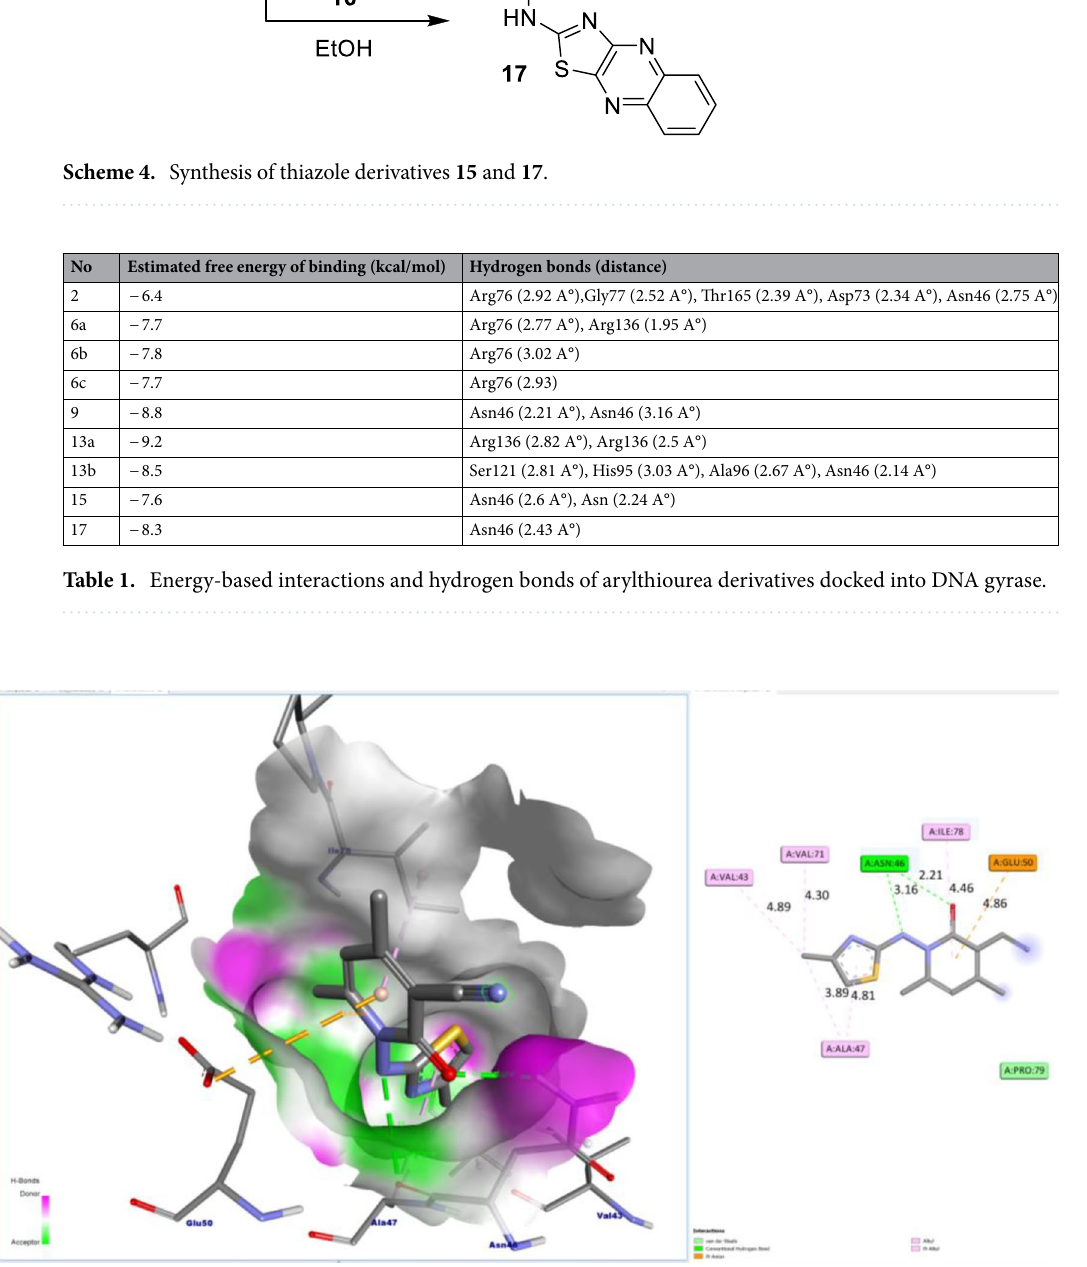
Figure 3. Docked conformation of compound 9 in the binding site of DNA-gyrase. Hydrogen bonds are shown by green dashed line and the other colors represent the hydrophobic